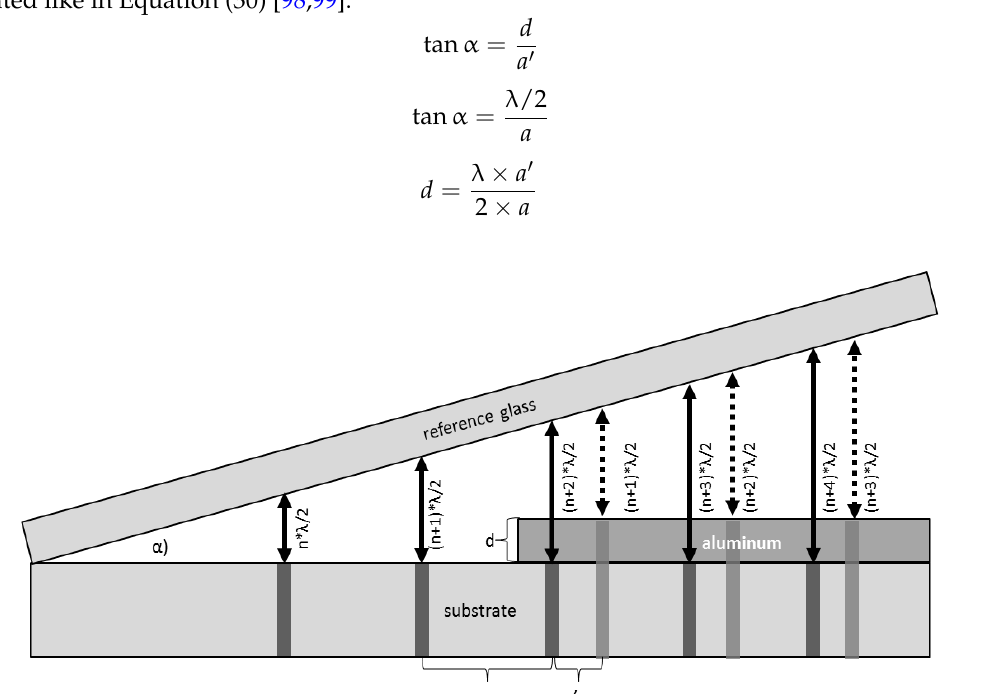
Figure 17. Appearance of interference bands on the semitransparent reflecting coating.